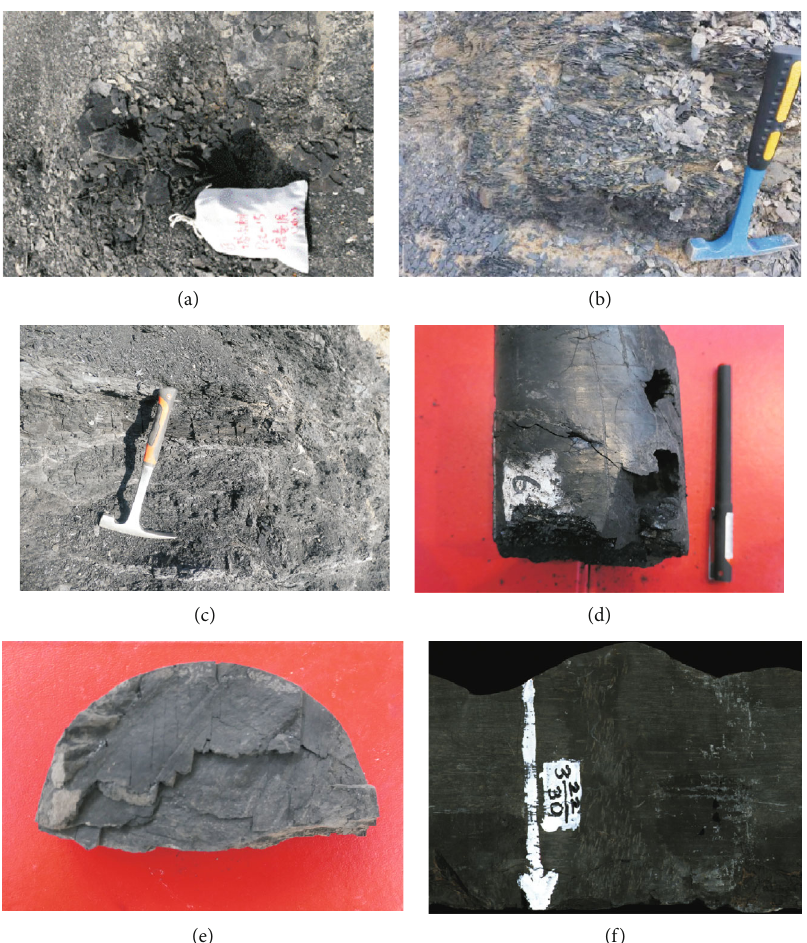
Figure 3: The petrological photos of typical source rocks. (a) The Permian dark mudstone in Taerlanggou. (b) The Permian dark mudstone in Zhaobishan (according to literature [24]). (c) The Xishanyao Formation coal in Ertanggou. (d) The Xishanyao Formation coal of well He6 in Hetaogou area. (e) The Badaowan Formation dark mudstone of well A2 in Aketashi area. (f) The Badaowan Formation dark mudstone of well Ke28 in Aketashi